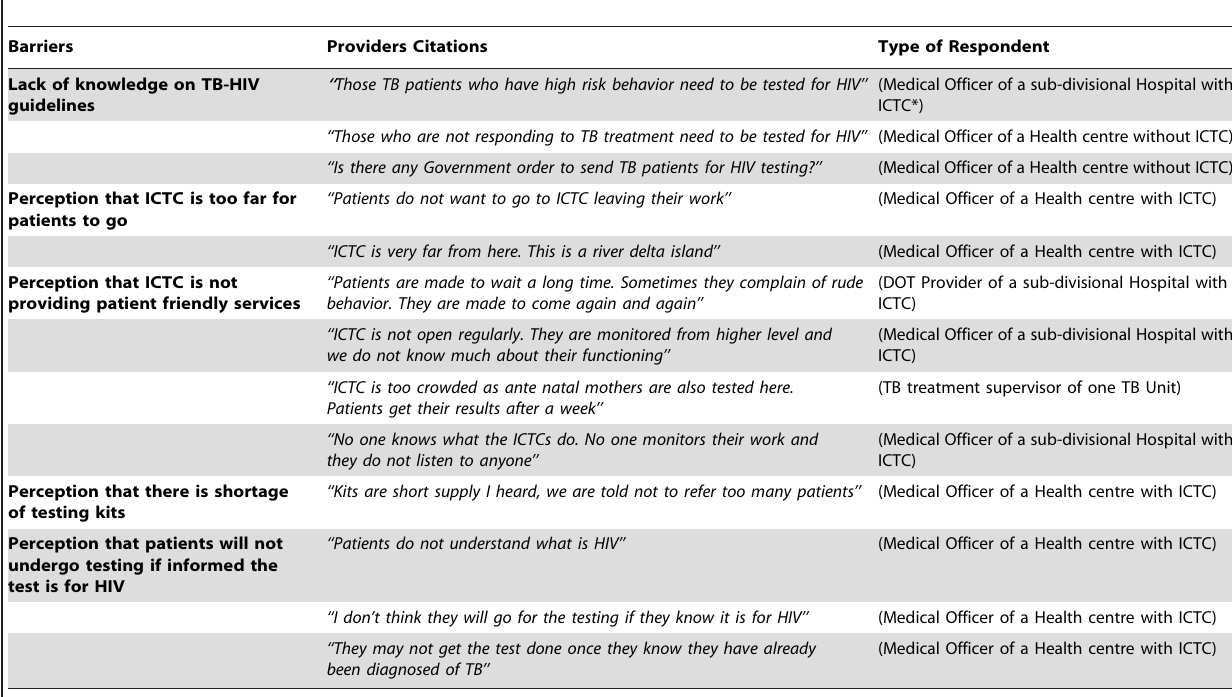
Table 5. Perception of Providers on barriers to HIV testing for people with TB in South 24 Parganas District, West Bengal, India.